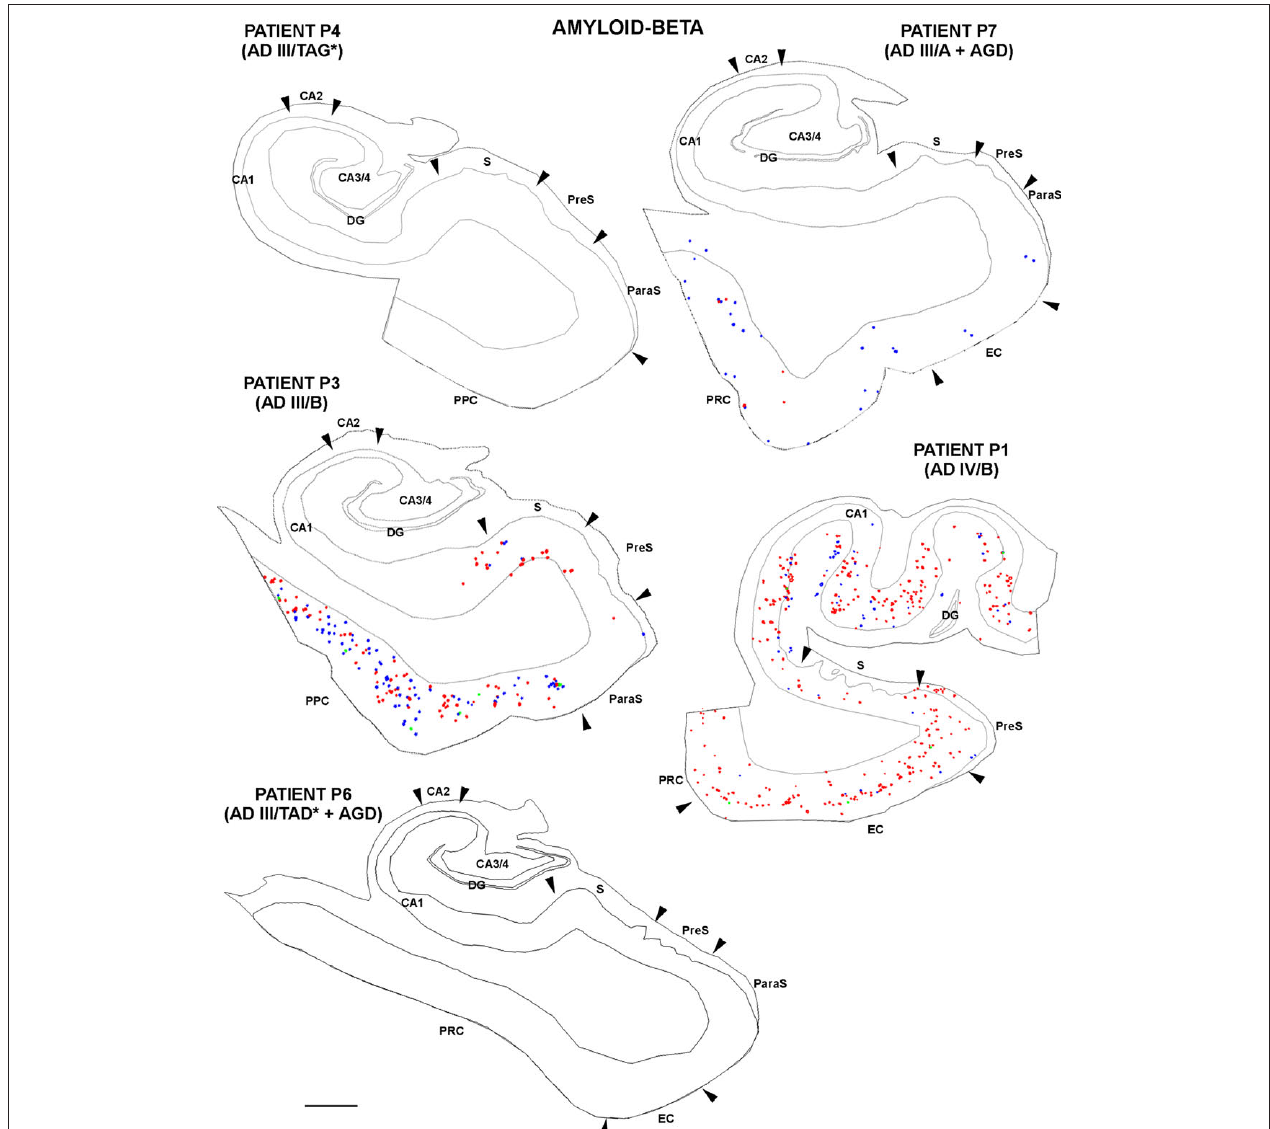
et al., 2009 ) in the hippocampal formation and adjacent cortex from AD cases. Borders between the different cortical cytoarchitectonic regions are indicated by arrowheads. Abbreviations as in Figure 5 . Scale bar: 1,000